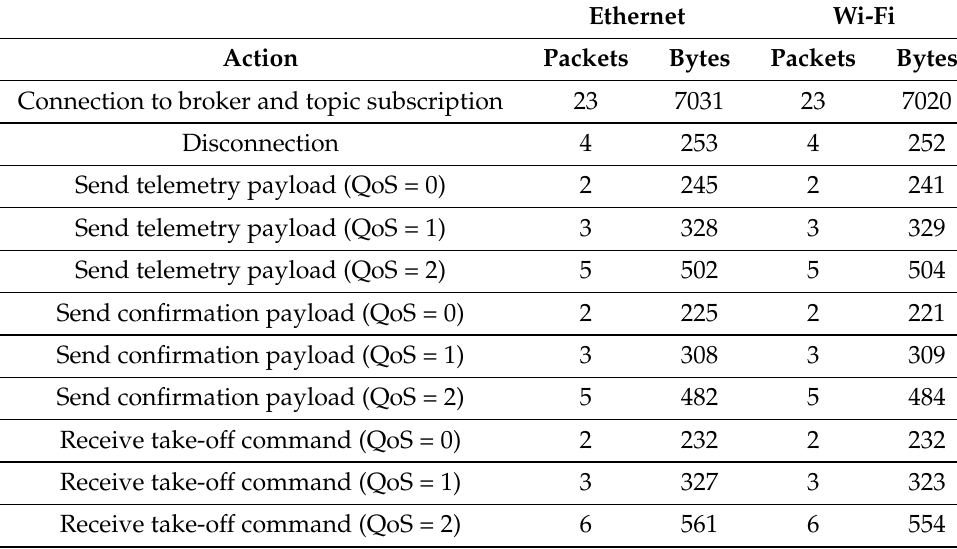
Table 2. Tasks measured on Ethernet and Wi-Fi connections.